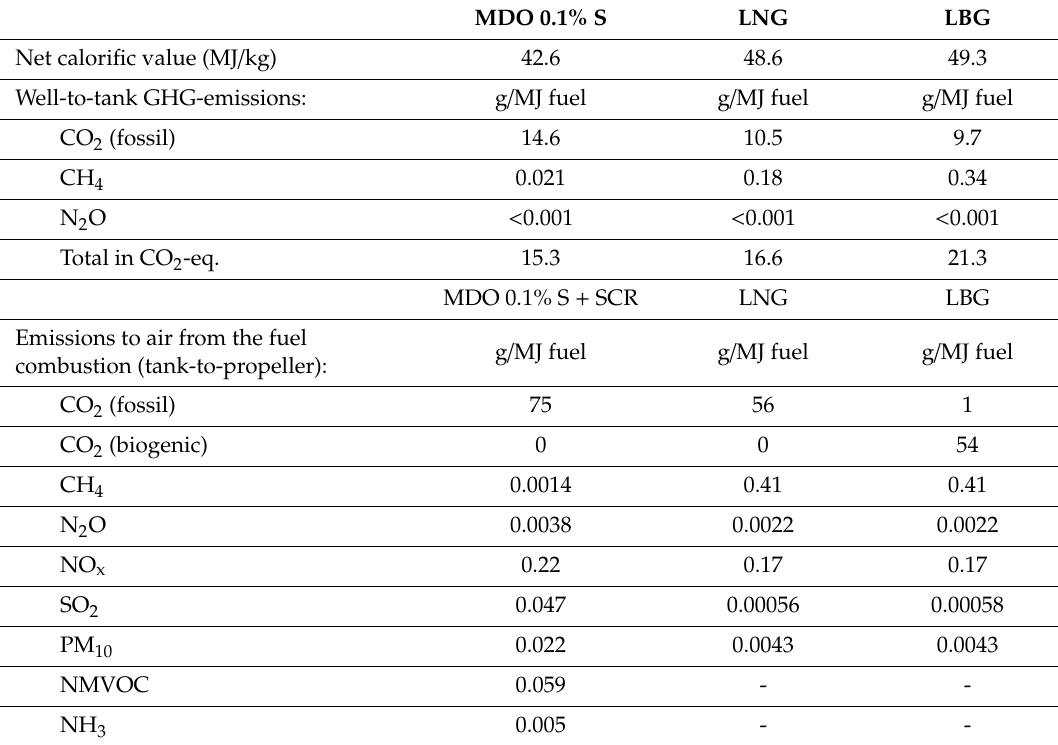
Table 3. Summary of emissions to air from well-to-tank and